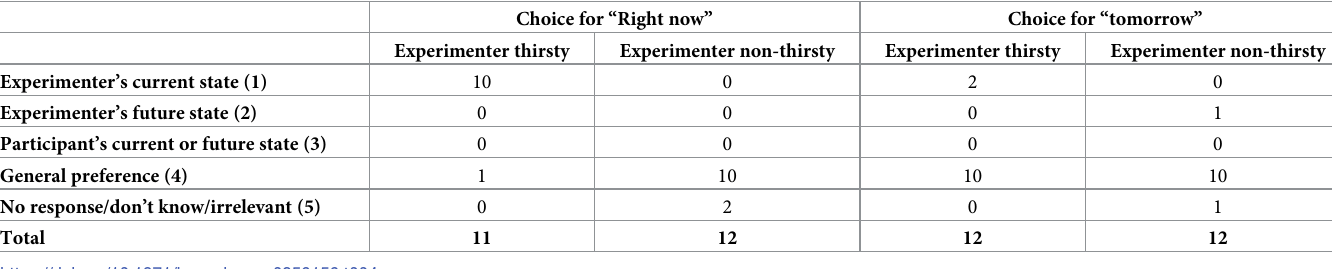
Table 4. Adults’ explanations for the experimenter for the “choice right now” and “choice for tomorrow” by condition. Choice for “Right now” Choice for “tomorrow” Experimenter thirsty Experimenter non-thirsty Experimenter